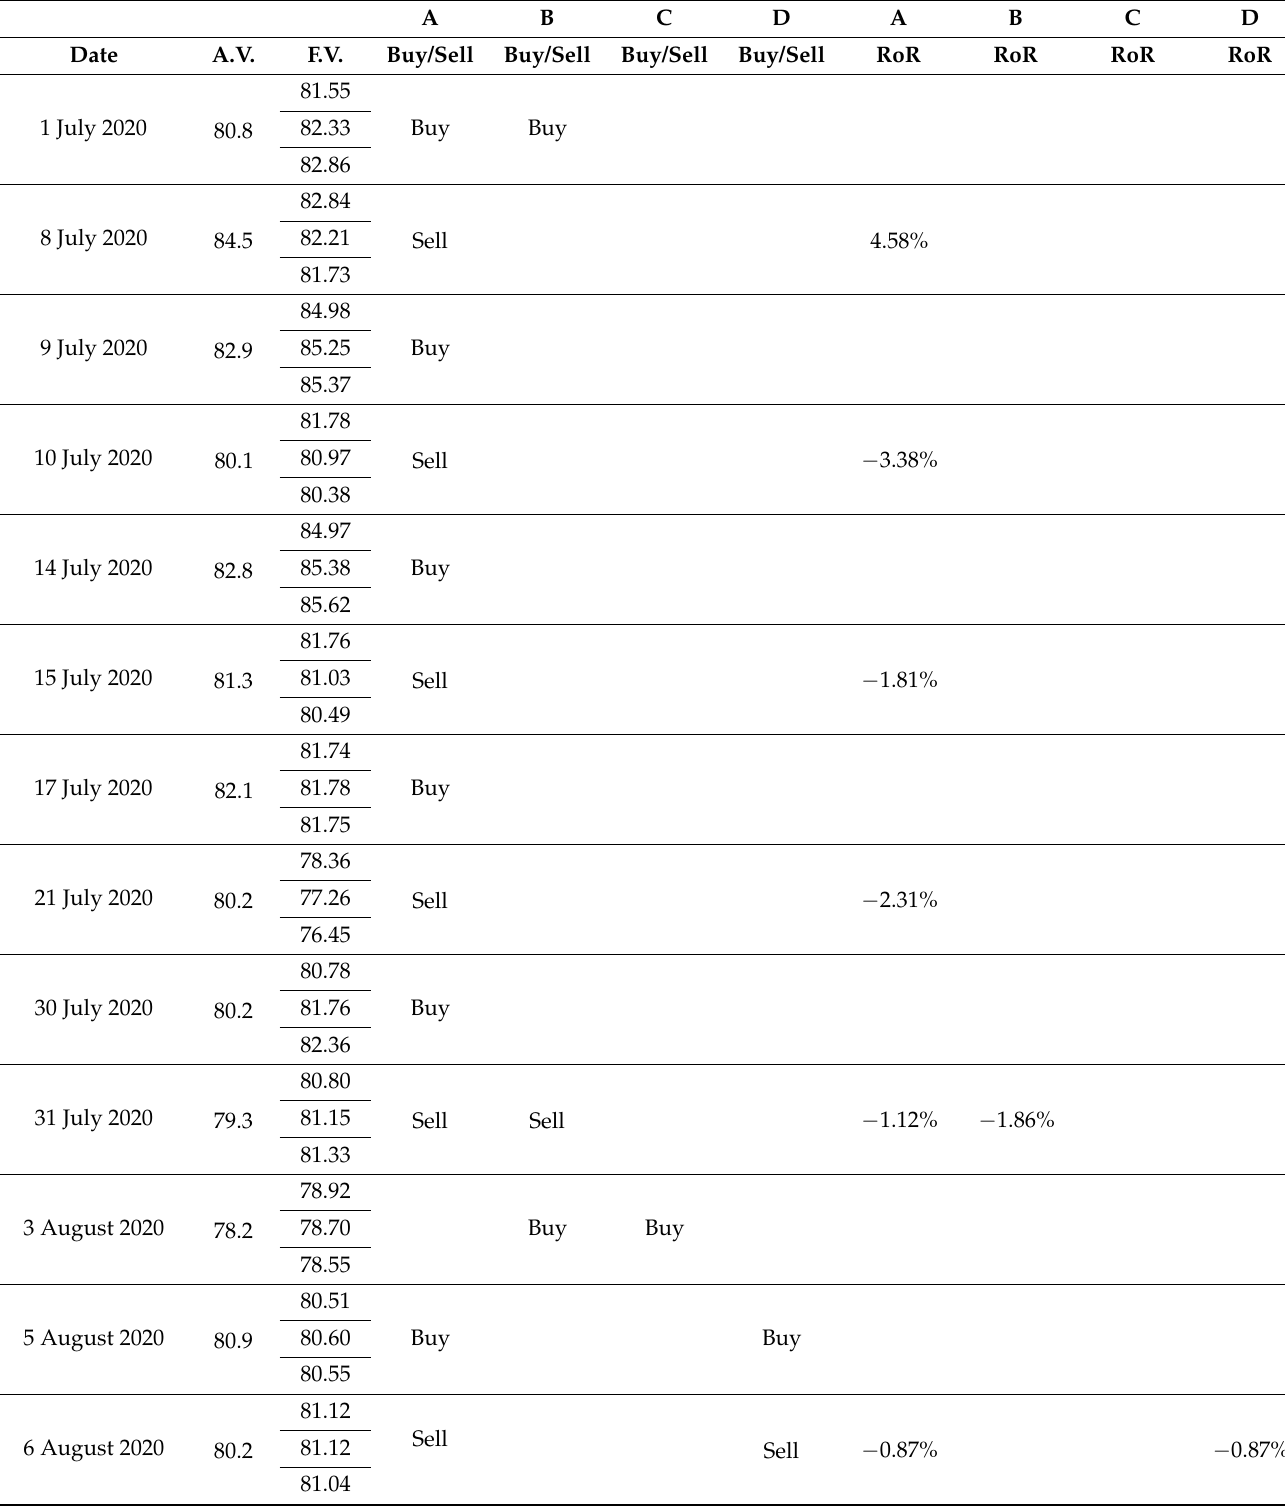
Table A1. Calculation of simulated transactional ROR of 6111 Softstar in 2020 (ARIMA (1,1,0)). A